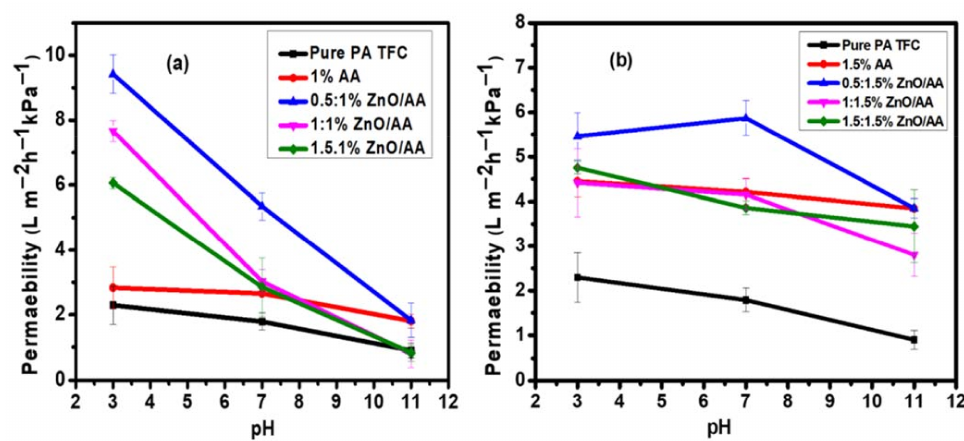
Figure 8. Water permeability of: ( a ) membranes modified with 0.00% AA, 1.00% AA, 0.50:1.00% ZnO/AA, 1.00:1.00% ZnO/AA, and 1.50:1.00% ZnO/AA; and: ( b ) membranes modified with 1.50% AA, 0.50:1.50% ZnO/AA, 1.00:1.50% ZnO/AA, and 1.50:1.50%